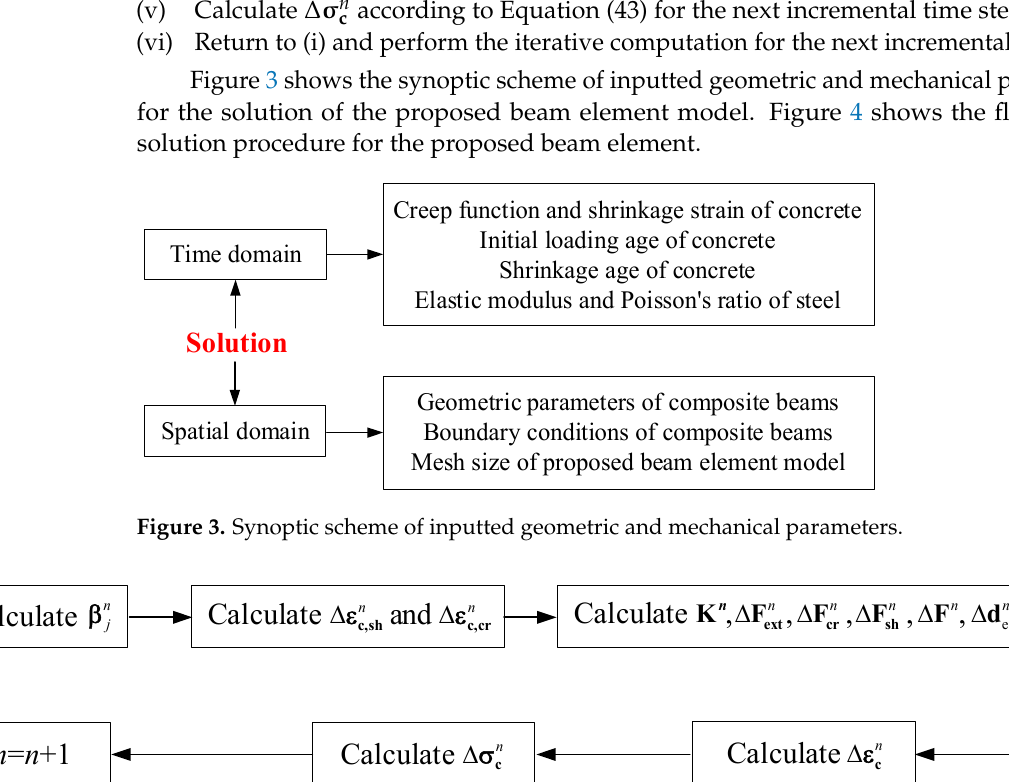
Figure 4. Flow of the solution procedure.